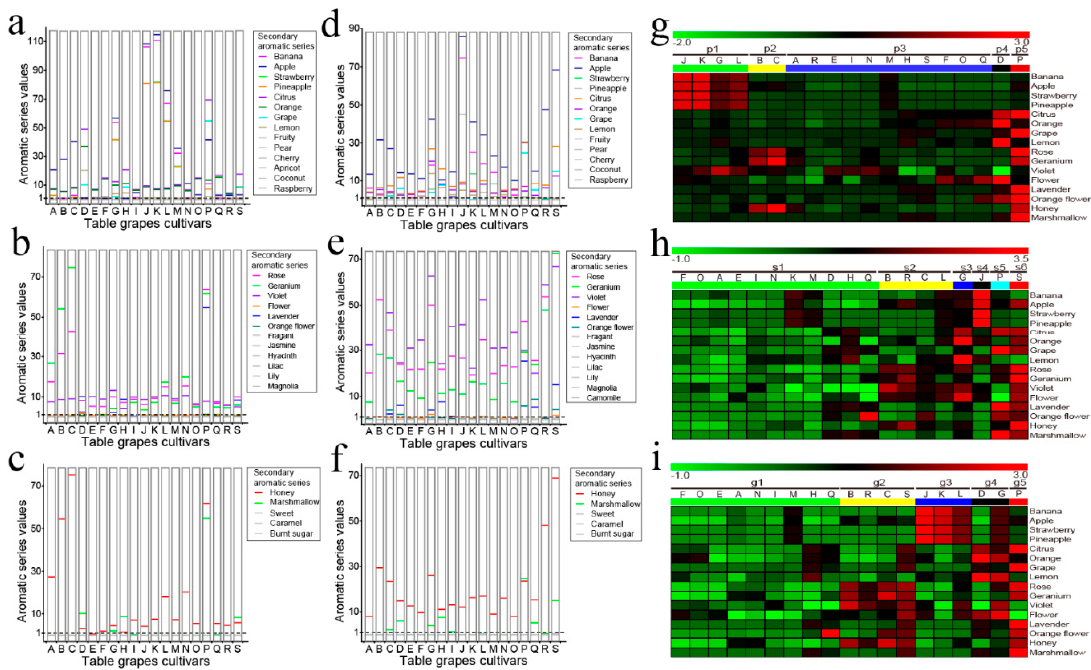
Figure 3. The secondary aromatic series values for pulp juice, ( a ) fruity, ( b ) floral, and ( c ) sweet; and for skin, ( d ) fruity, ( e ) floral, and ( f ) sweet. The values are odor activity values (OAVs) of the aromatic series. The values for rose, banana, apple, strawberry, and pineapple of pulp juice, and rose of the skin represent half of the original values. The gray secondary aromatic series represent values less than 1, and hence, no active aroma. ( g – i ) The heatmaps indicate the active secondary aromatic series of every cluster obtained from hierarchical cluster analysis (HCA) analysis (Figure S2, ( a ) pulp juice, ( b ) skin, and ( c ) whole berries). Bars represent mean ( n = 3 biological replications). The bottom upper-case letters represent the unfamiliar table-grape cultivars, as listed in Figure